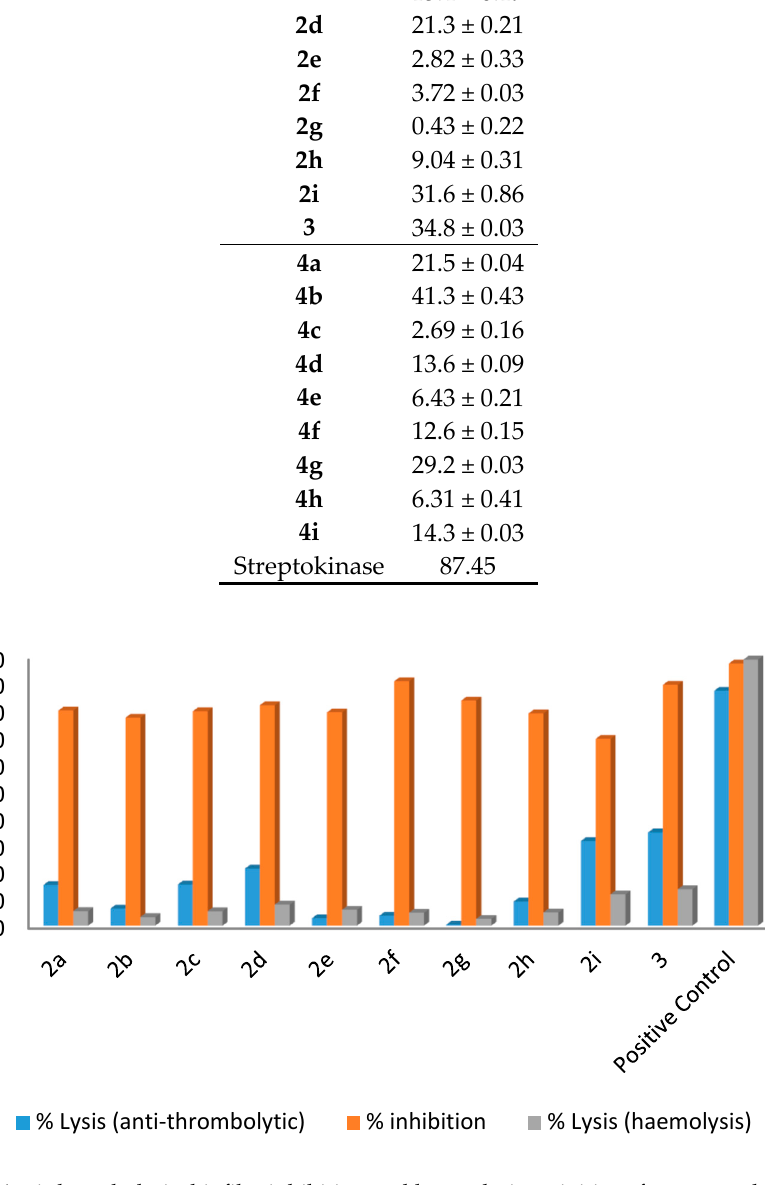
Figure 3. Anti-thrombolytic, biofilm inhibition and haemolytic activities of compounds 2a – 2i , 3